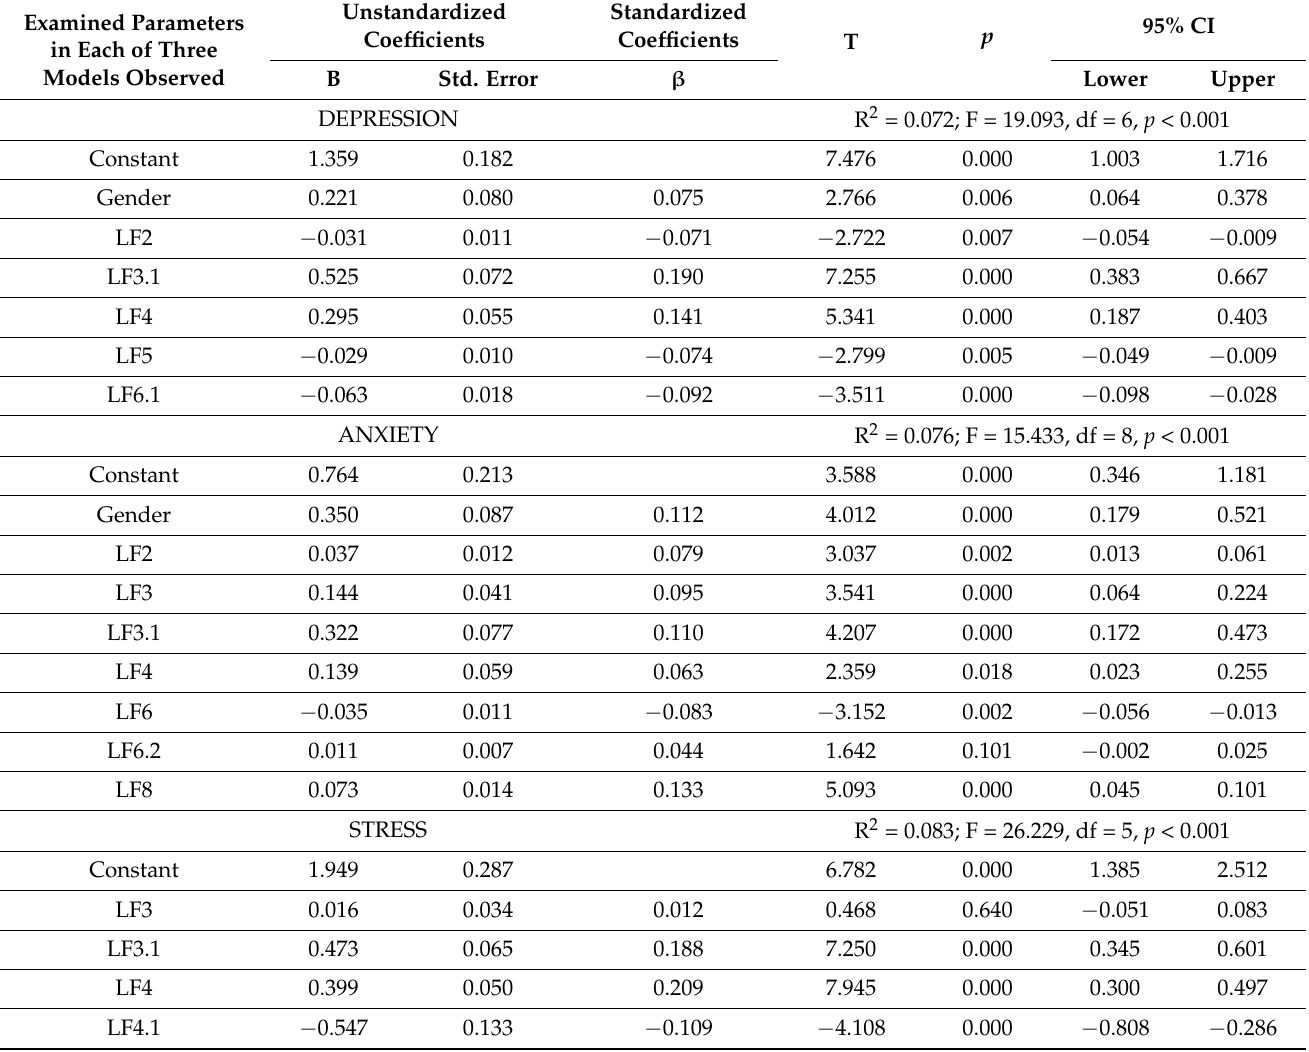
Table 4. Multiple linear regression analysis of depression, anxiety, and stress scores as continuous dependent variables with observed